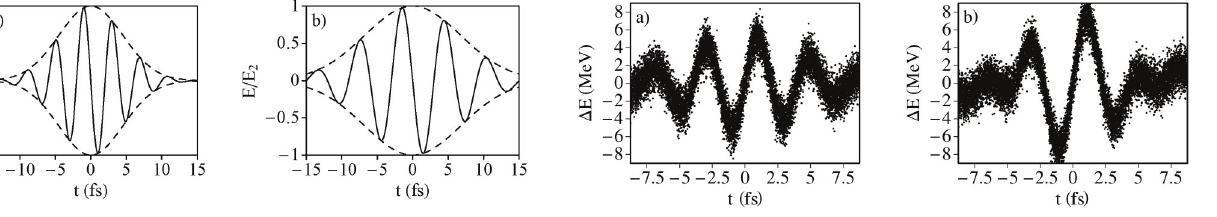
FIG. 2. A snapshot of the laser electric field normalized to the FIG. 4. (a) The calculated energy modulation of the electrons peak value: (a) 1200 nm laser wavelength and 7.5 fs pulse along the electron bunch produced in the interaction with a few- (FWHM of intensity); (b) 1600 nm laser wavelength and 10 fs cycle, 1200 nm laser pulse in the wiggler magnet; (b) the combined energy modulation from a few-cycle, 1200 nm laser pulse in one wiggler magnet, and a few-cycle, 1600 nm laser pulse in a second wiggler magnet. (cid:2) Z (cid:5)=(cid:8) , which is assumed to be center is defined by w 2 R 0 larger than the electron beam size.